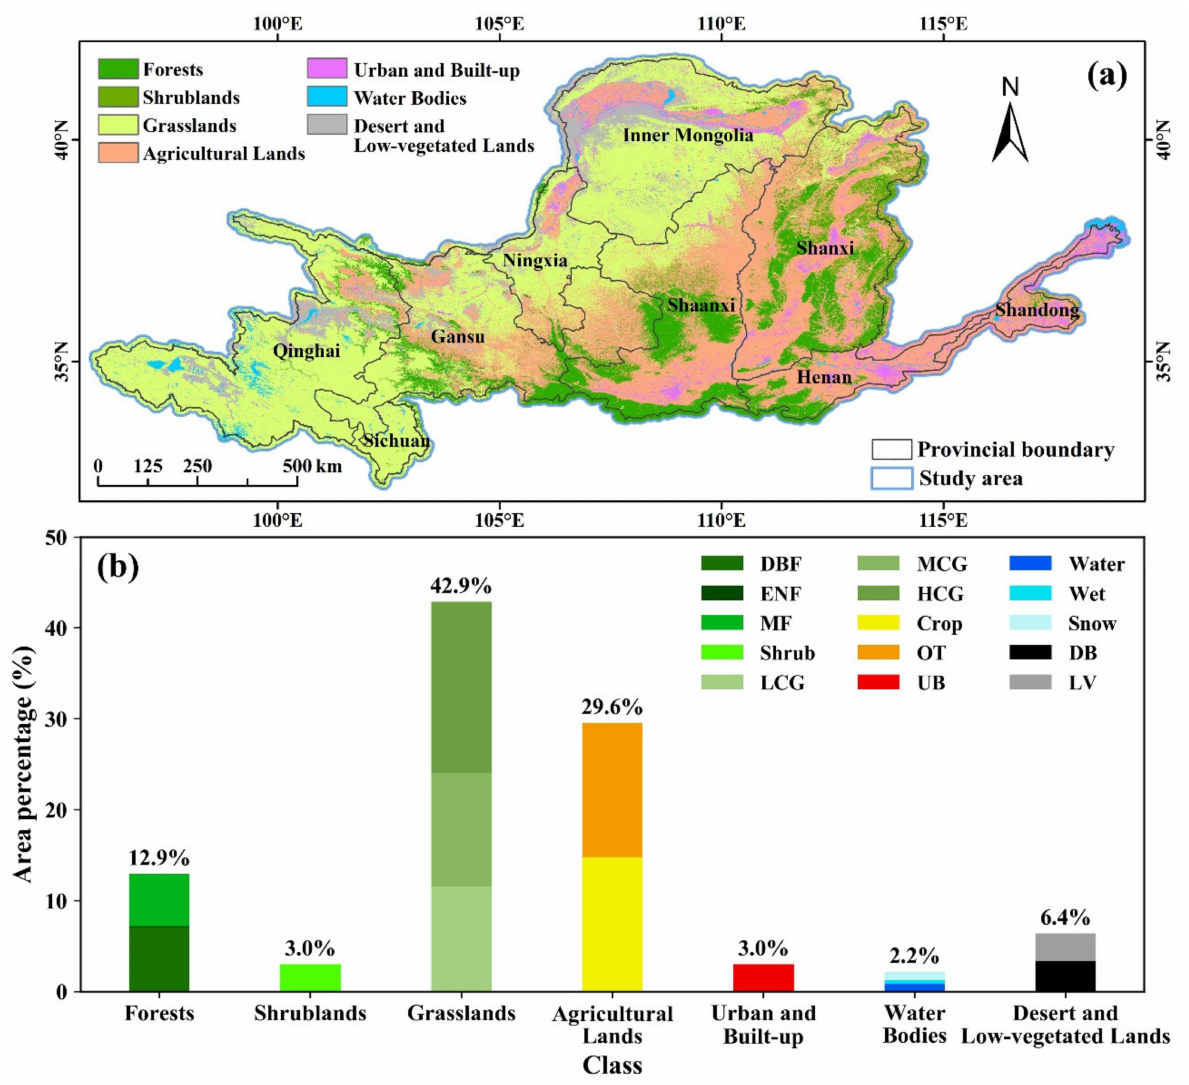
Figure 3. ( a ) Spatial distribution of land use/cover of the Yellow River basin in 2018 and ( b ) the average area percentage of each land use/cover class during the study time period. The abbreviation of each class in Figure 3b can be found in Table